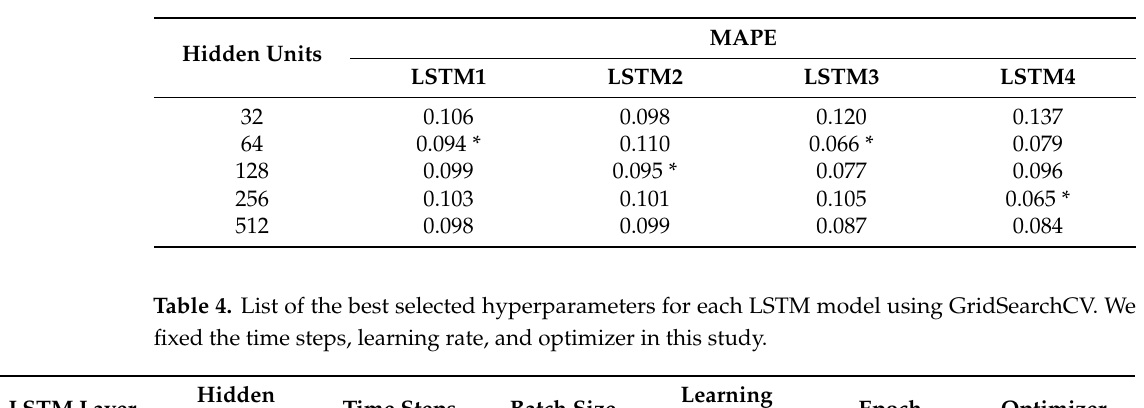
Table 3. The best hyperparameter for hidden units. Hidden units for LSTM1 to LSTM4 were selected as 64, 128, 64, and 256, respectively. * represents the smallest MAPE values for each model.